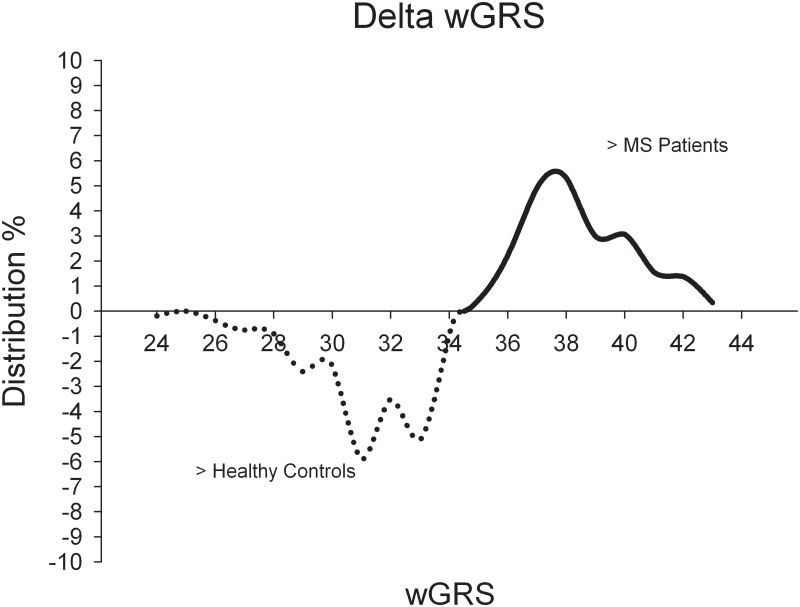
Delta wGRS.Percentage distribution of the ΔwGRS = wGRSMS - wGRScontrols. The dotted line depicts a higher distribution for the corresponding wGRS in the healthy controls and the continuous line depicts a higher distribution for the corresponding wGRS in MS-patients. χ2-testing for wGRS>34.5 as risk factor, two tailed p-value 2.4*10–16 (OR = 2.516; 95% C.I. of 2.003–3.160).